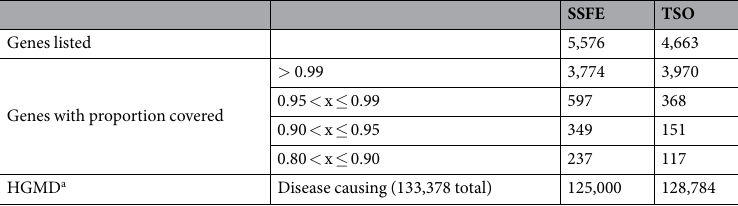
Table 2. Region of interest coverage. a Human Gene Mutation Database release 2015 23